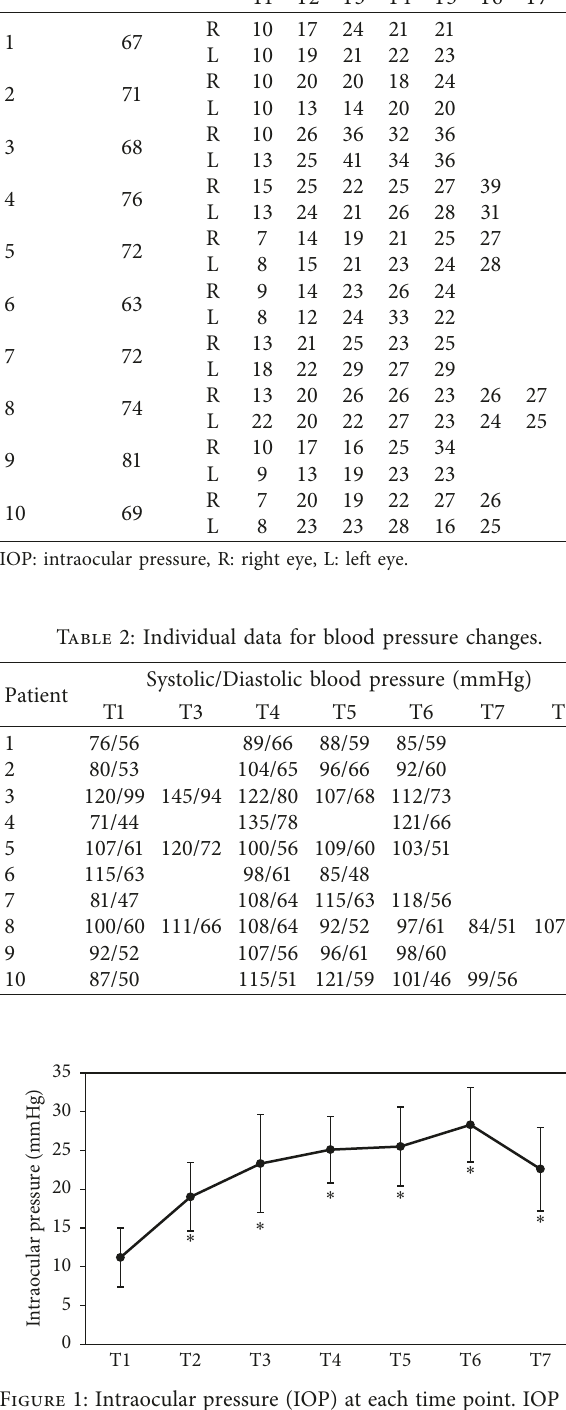
Table 1: Individual data for IOP changes. Patient Age (yrs) R/L